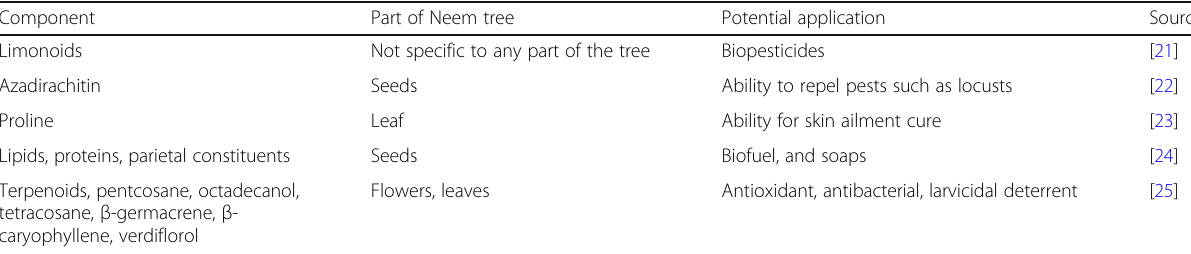
Table 1 Composition of Neem extracts from seeds, leaves, flowers Component Part of Neem tree Potential application Source Limonoids Not specific to any part of the tree Biopesticides Azadirachitin Seeds Ability to repel pests such as locusts Proline Leaf Ability for skin ailment cure Lipids, proteins, parietal constituents Seeds Biofuel, and soaps Terpenoids, pentcosane, octadecanol, Flowers, leaves Antioxidant, antibacterial, larvicidal tetracosane, β -germacrene, β - caryophyllene, verdiflorol